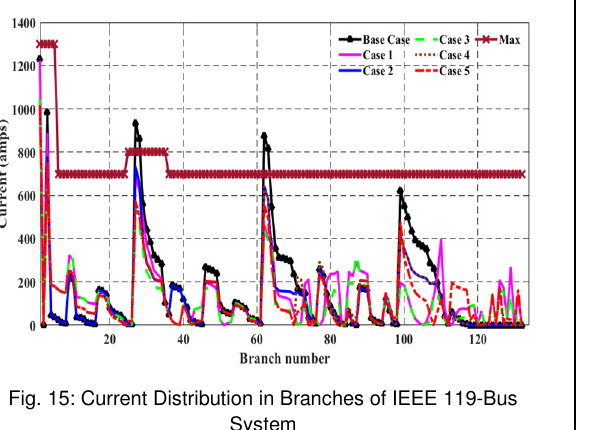
Fig. 15: Current Distribution in Branches of IEEE 119-Bus System